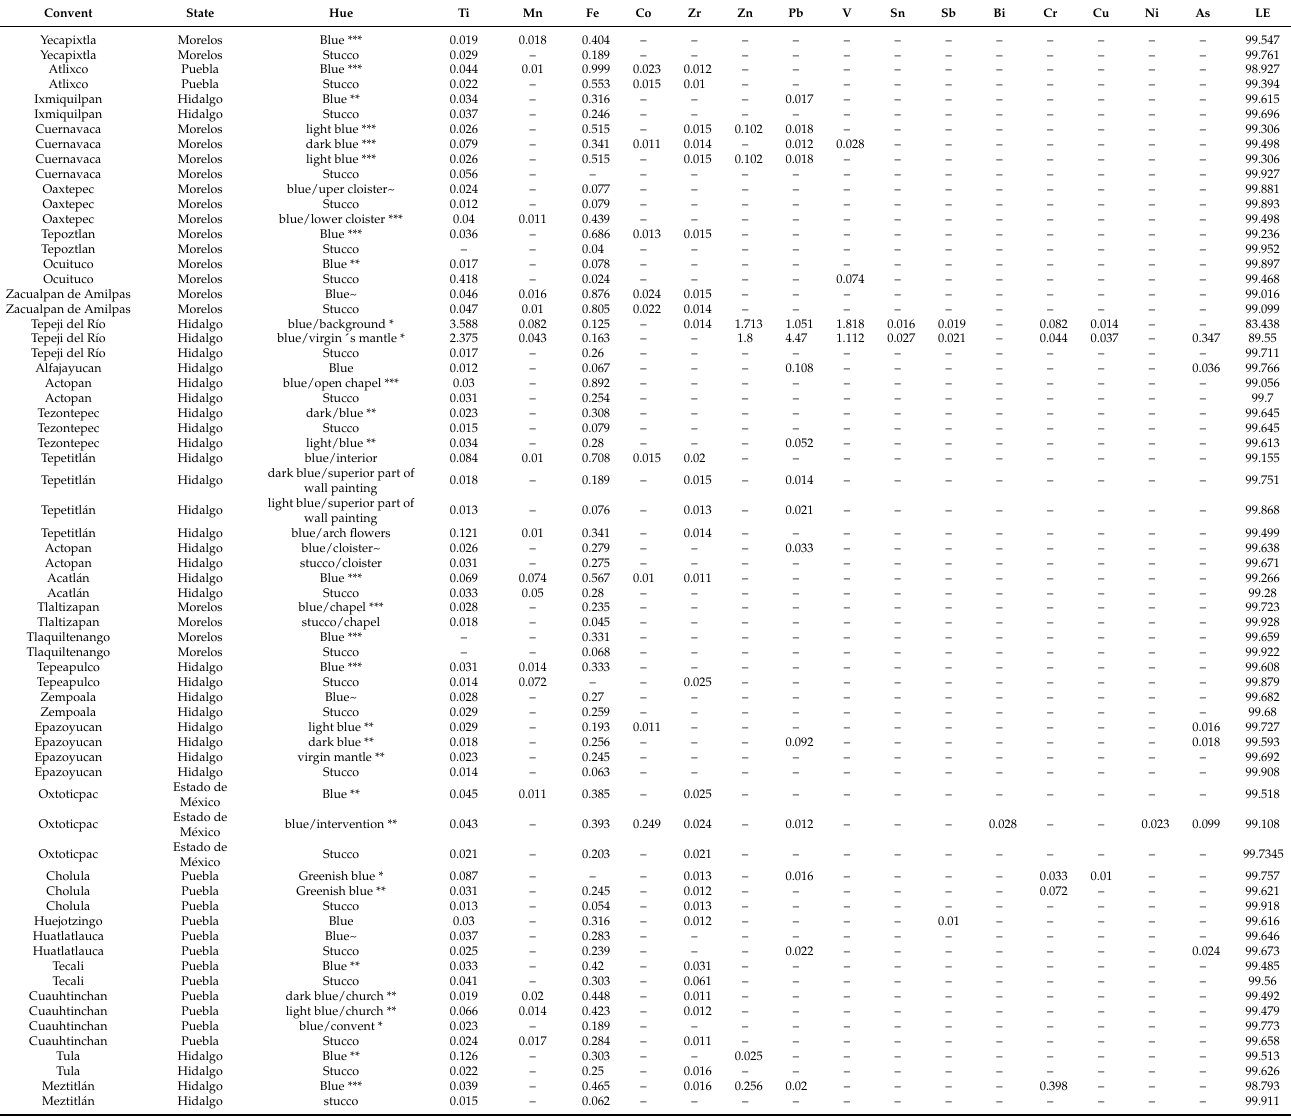
Table A1. Elemental analysis obtained with